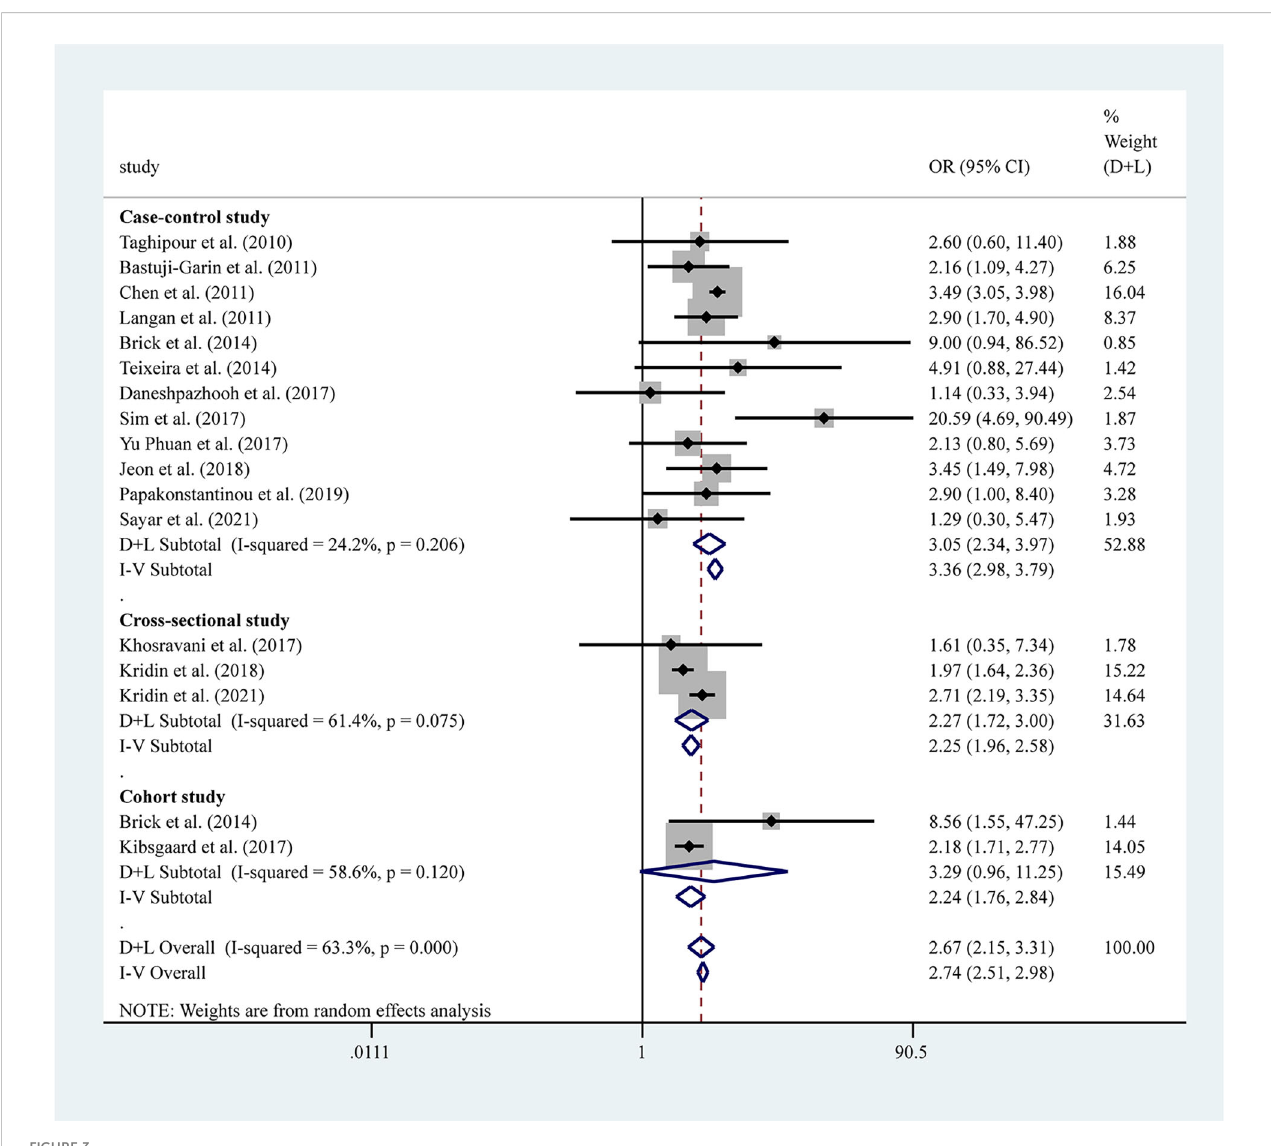
FIGURE 3 Forest plots of studies association between PD and